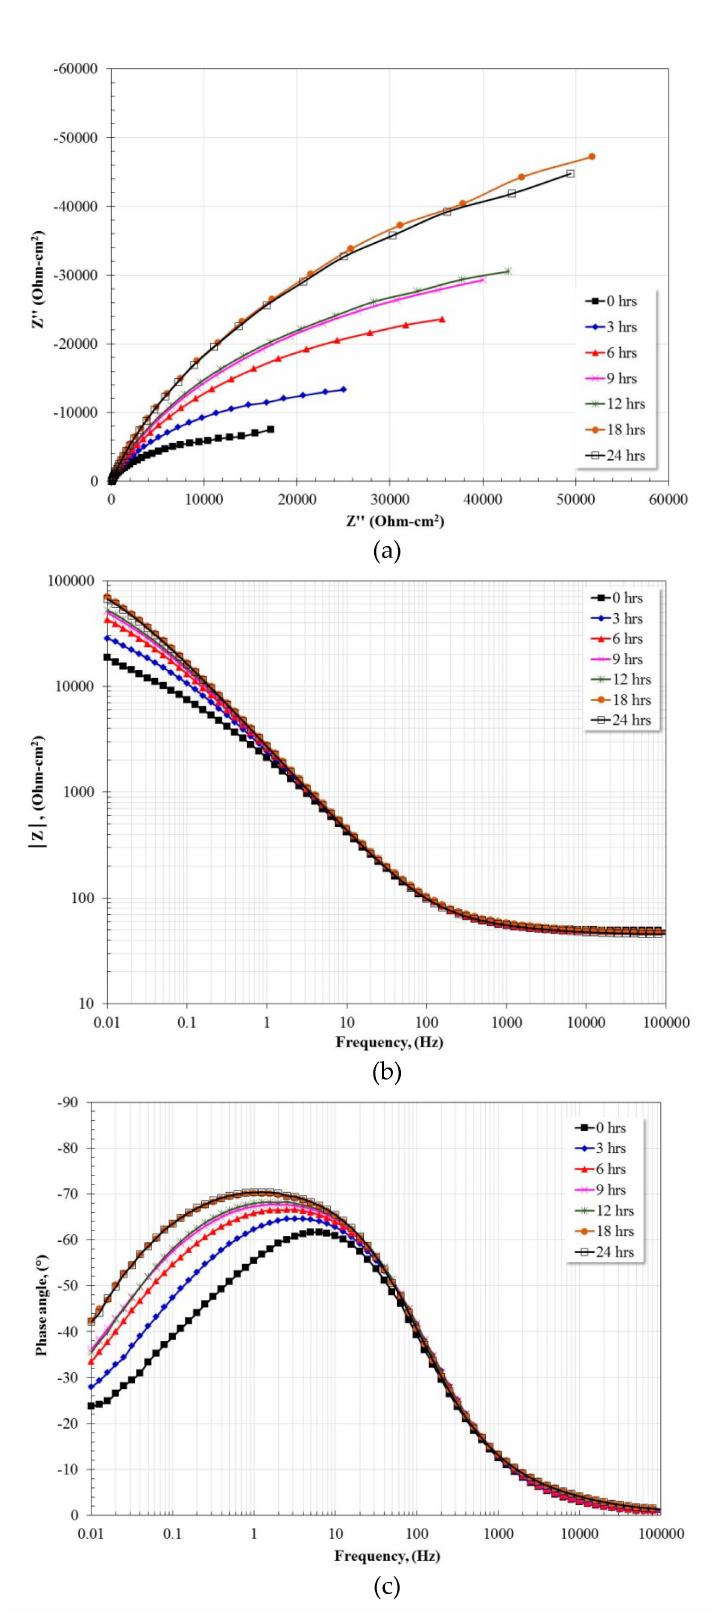
Figure 7. Nyquist ( a ) and Bode ( b , c ) plots for Fe40Al exposed in artificial saliva at 37 ◦ C after 24